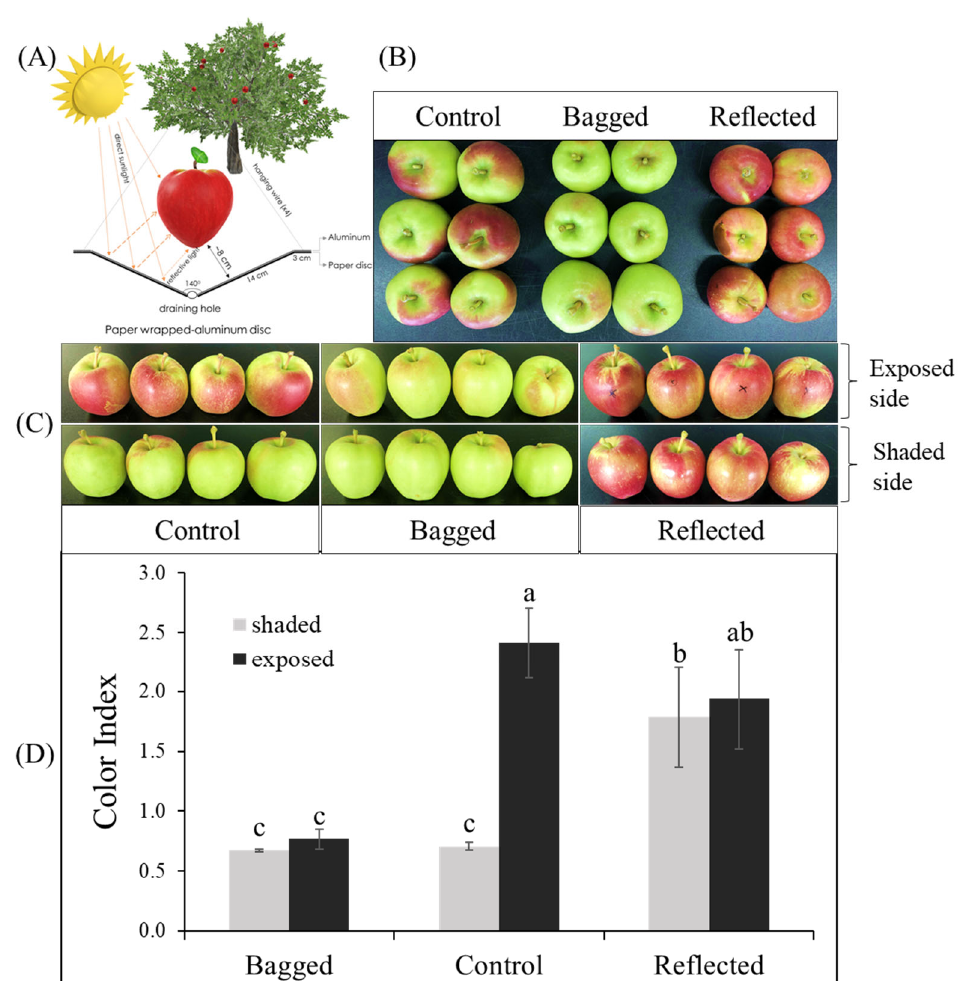
Figure 1. For the reflected sunlight treatment, the fruit was set up with a paper wrapped-aluminum disc to increase light intensity on the fruit of apple ‘Arisoo’ ( A ). The fruits showed a different coloration pattern between the three groups: reflected sunlight, bagged, and control ( B ), and between the exposed and shaded sides in the same fruit ( C ). The red-coloration level was positively correlated with color index ( D ). Different letters above the bars indicate a significant difference ( p < 0.05). Data are presented as mean ± SD ( n = 20) of three biological